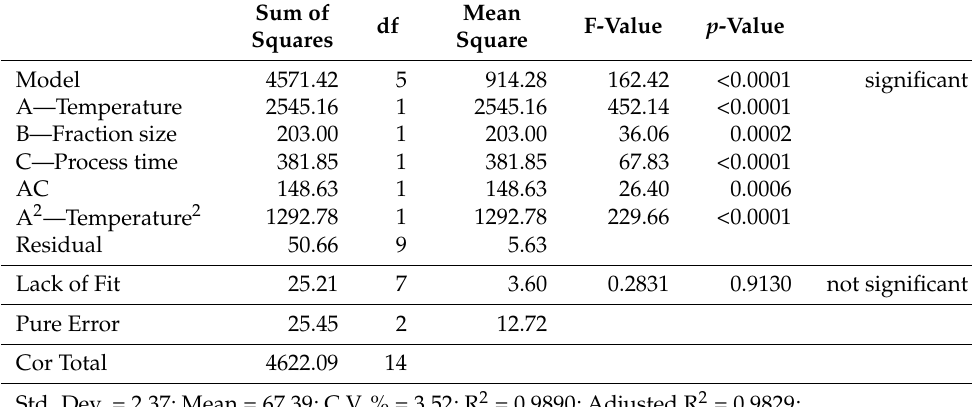
Table 6. The analysis of variance for total